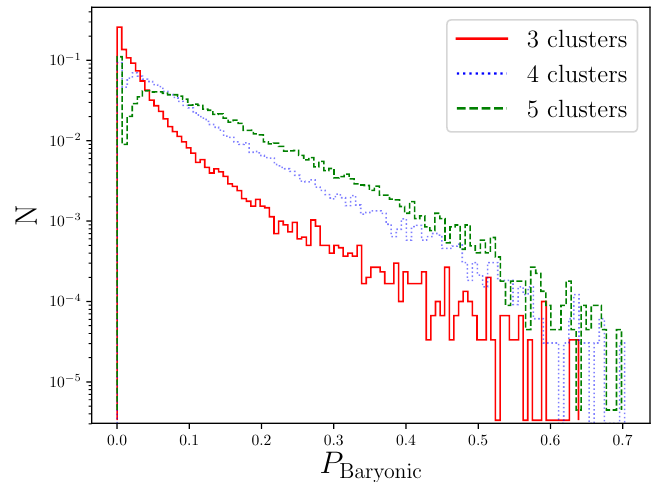
Figure 7 . Histogram of baryonic reconnection probabilities for three, four and (cid:12)ve cluster evolution where the quark kinematics was sampled with the RAMBO phase space